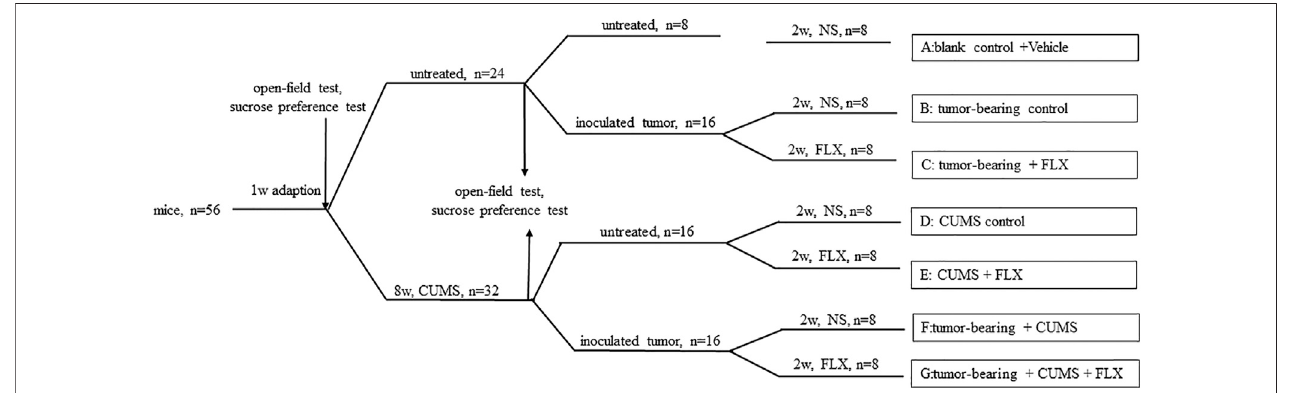
FIGURE 1 | Schematic representation of experimental